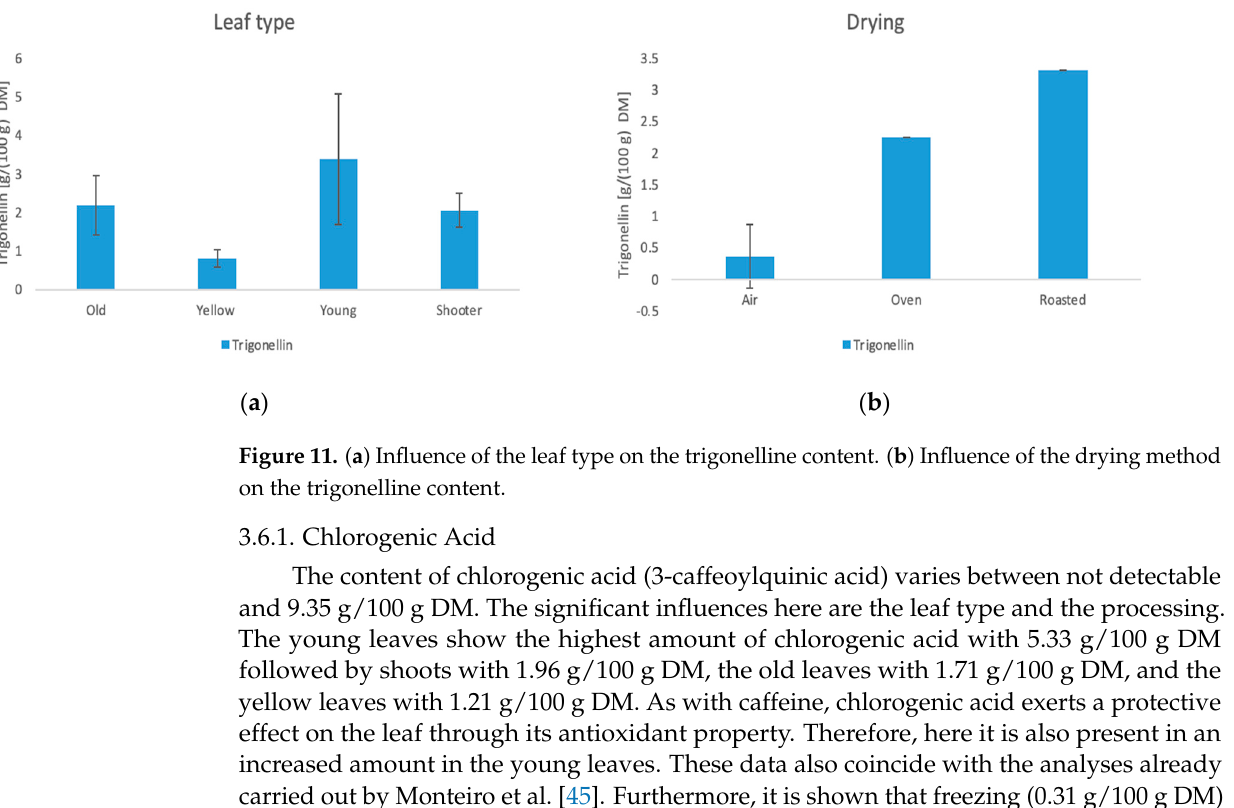
Figure 10. ( a ) Influence of the processing method on the acetic acid content. ( b ) Influence of the fermentation on the acetic acid content.